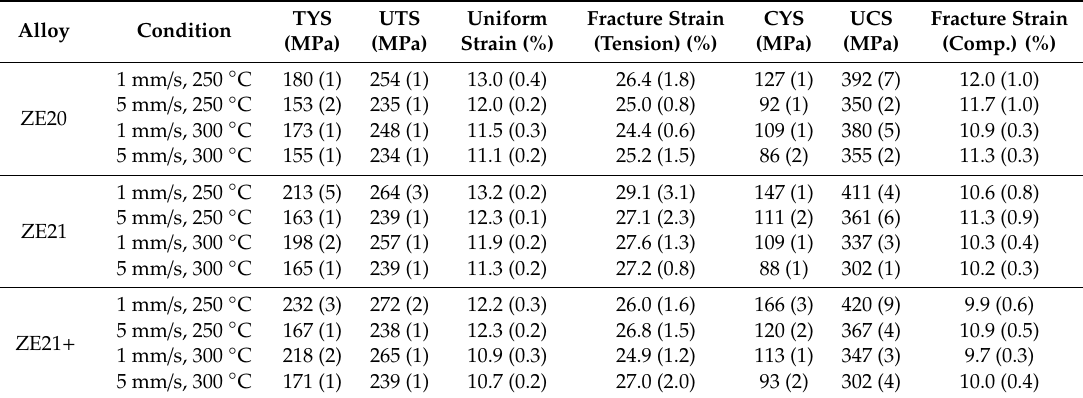
Table 4. Mechanical properties from tensile and compression tests in Figure 4 for the ZE-series alloys TYS: tensile yield stress, UTS: ultimate tensile stress, CYS: compressive yield stress, UCS: ultimate compressive stress; errors in